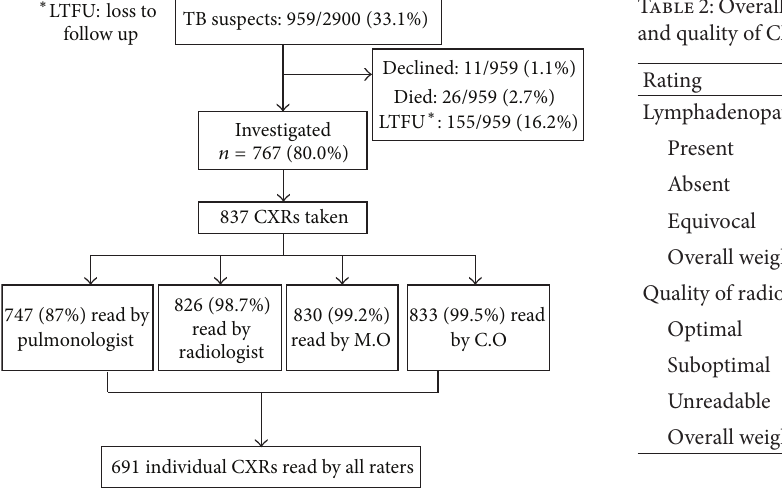
Figure1:ProfileofTBsuspectsandchestradiographsreadperrater.